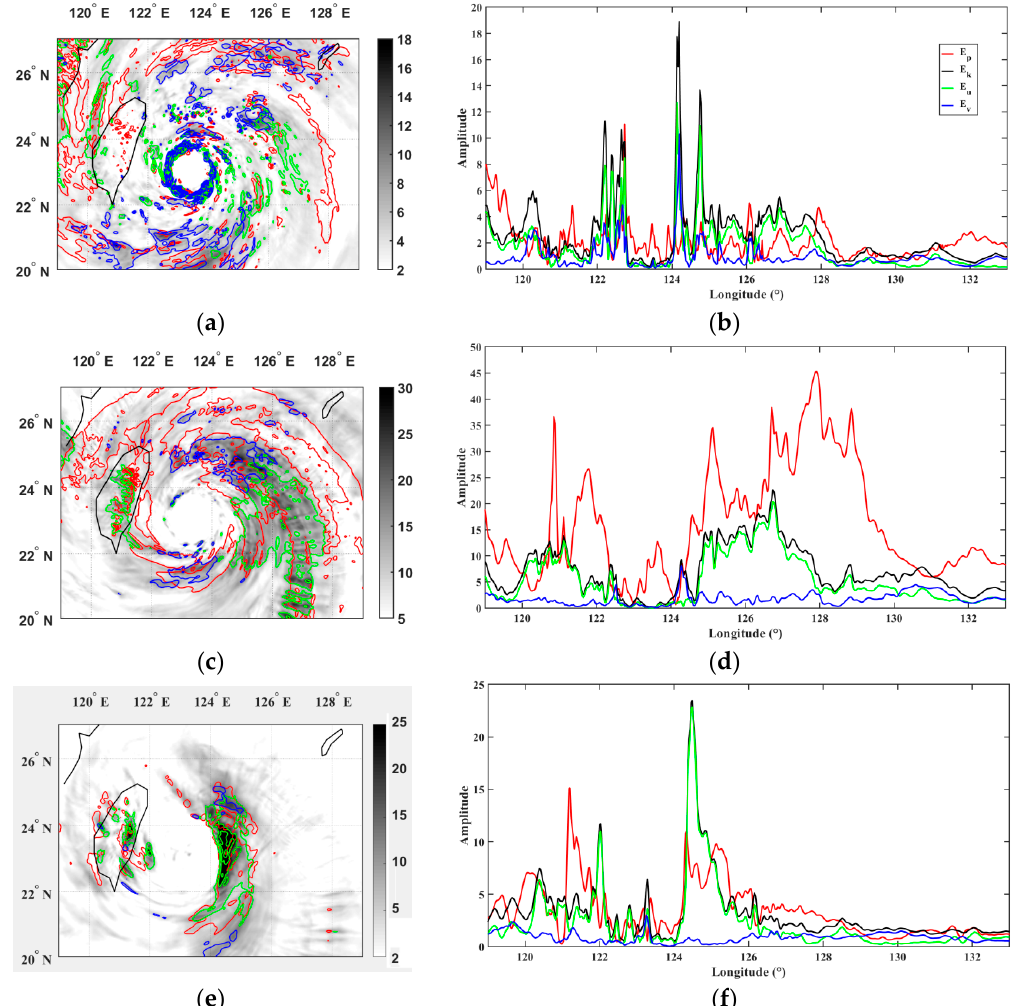
Figure 9. Mean kinetic energy distribution E k (J kg − 1 ) from horizontal wind perturbations (grey shading) at heights of ( a ) 3–10 km, ( c ) 8–15 km and ( e ) 18–25 km on 7 August 12:00 UTC. Contours of mean energy density (J kg − 1 ) derived from potential temperature ( E p , red), zonal wind ( E u , green) and meridional ( E v , blue) perturbations are superimposed. Longitudinal cross-sections of mean energy density distributions: ( b ) 3–10 km, ( d ) 8–15 km and ( f ) 18–25 km at latitude 23° N.